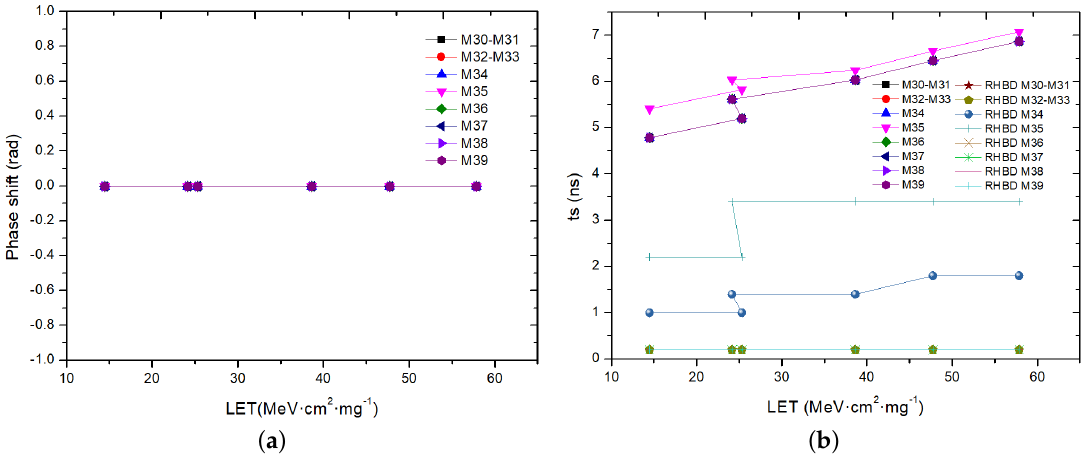
Figure 13. INP output of the RHBD CML2CMOS converter results. ( a ) Phase shift; ( b ) Recovery time.